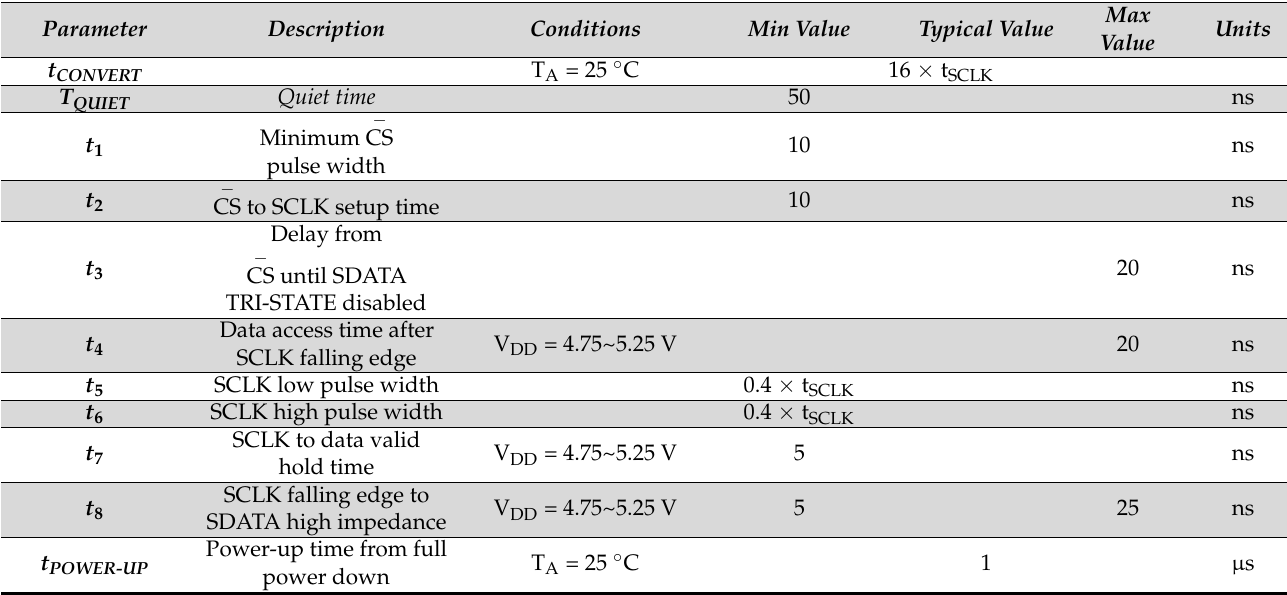
Figure 12. Serial interface timing diagram for the ADCS7476 [22]. Table 1. Timing requirements for the ADCS7476